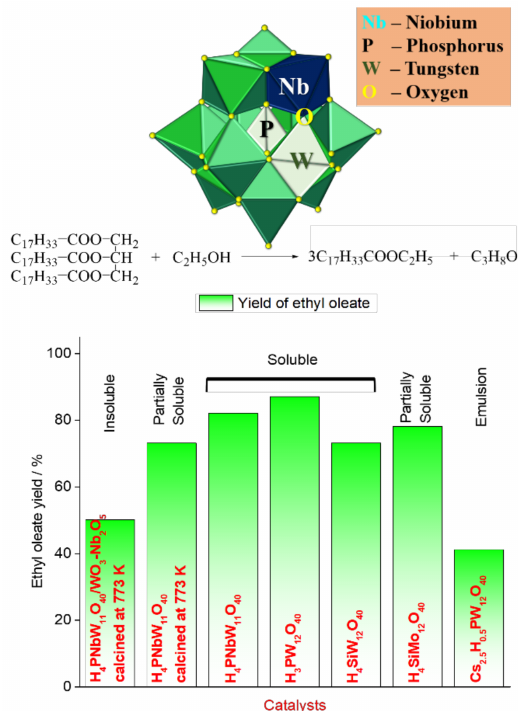
Figure 36. Schematic representation of the biodiesel production reaction catalyzed by the Keggin anion composed of Nb and yield of ethyl oleate by different heteropoly acids. Reaction conditions: